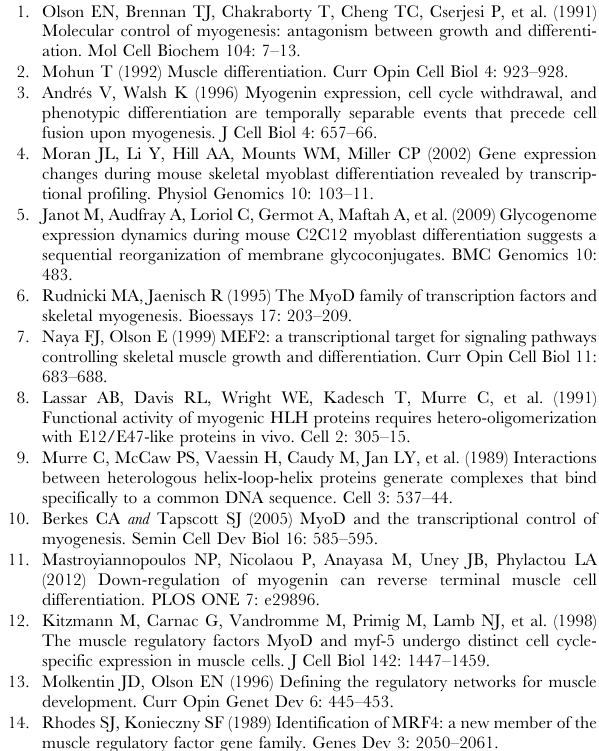
Table S2 List of up- and down-regulated genes. Each sheet contains up- and down-regulated genes separately that show at least 4 fold change in their expression. (XLSX) Table S3 GO functional annotation chart. GO functional annotation chart records for A ) up-regulated genes, and B ) Down- regulated genes. Only those terms that have p -values # 0.05 and number of genes in each term $ 5 are shown. (XLSX)